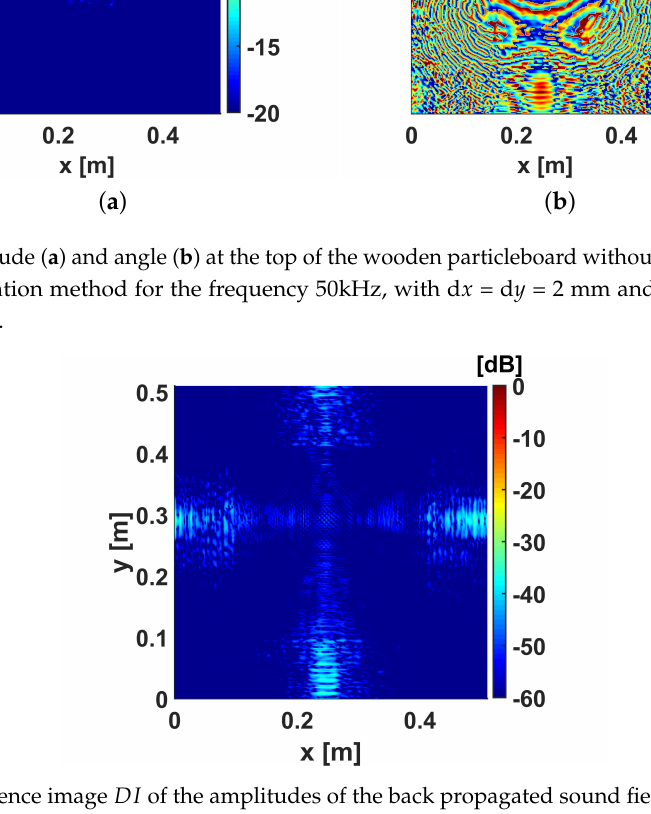
Figure 10. Difference image DI of the amplitudes of the back propagated sound field of the spec- and re-radiation method with an evaluation window size of 256 × 256 point.